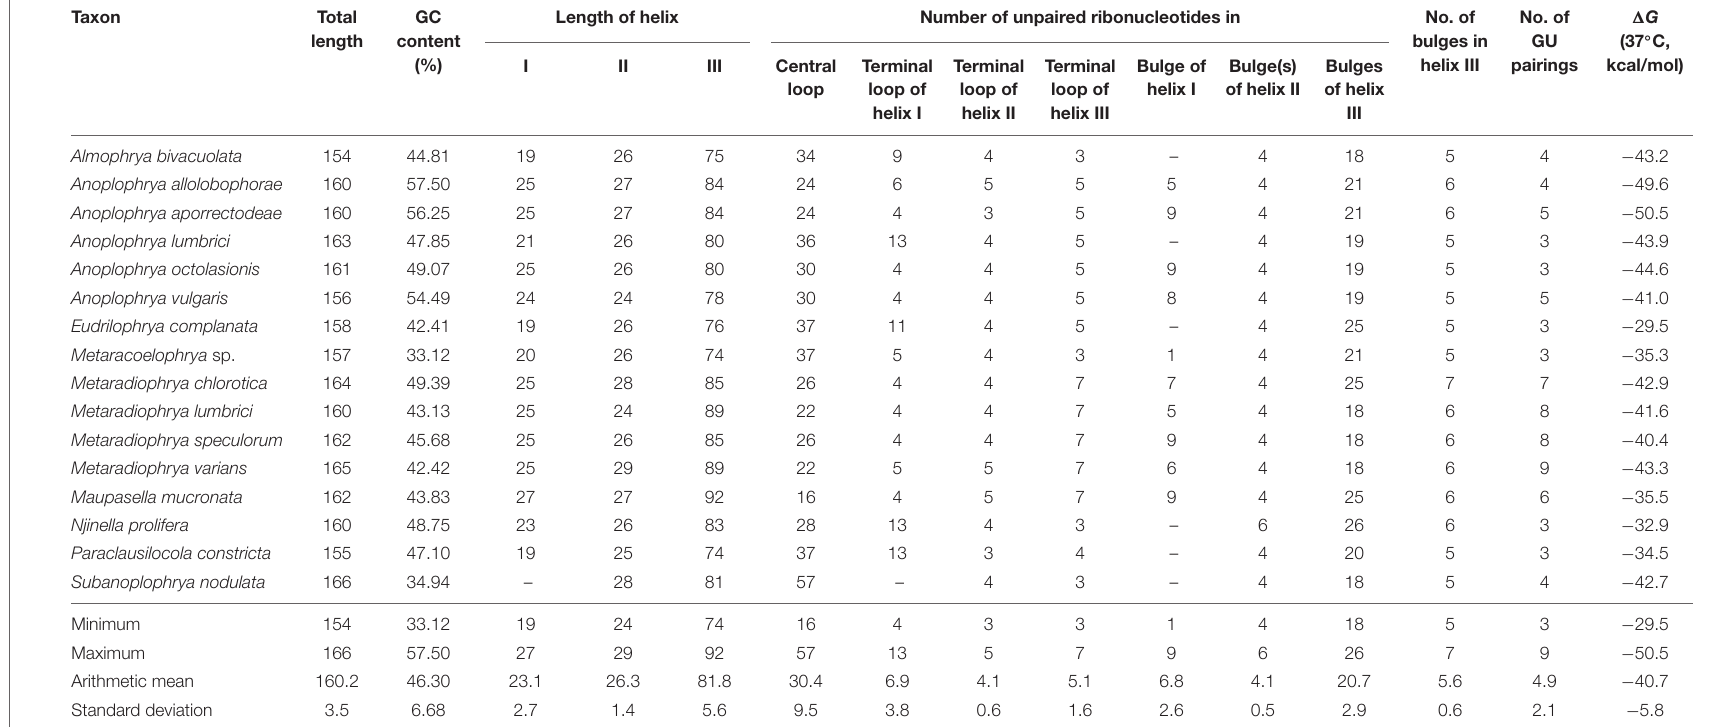
TABLE 2 | Characterization of ITS2 molecules of astome